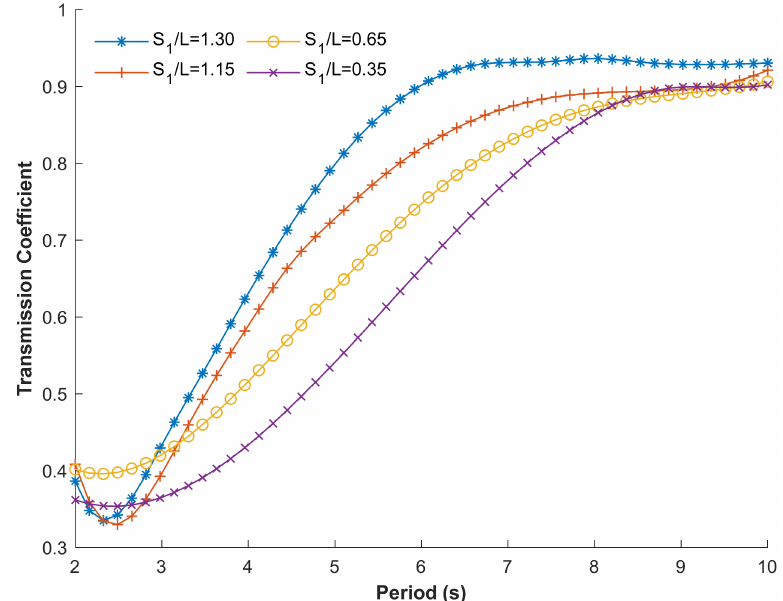
Figure 10. Impact of geometric parameters on transmission